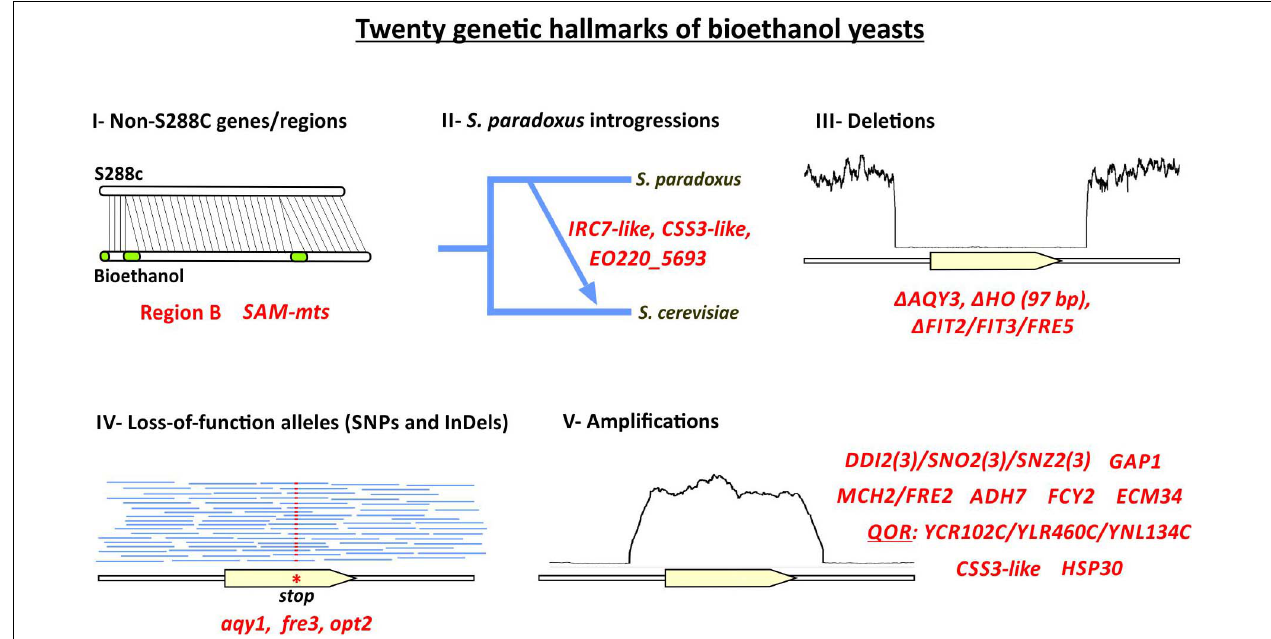
FIGURE 6 | Twenty genetic hallmarks of Brazilian bioethanol yeasts. Genetic features enriched ( p < 0.05) in bioethanol yeasts are shown in red, including: (i) non-S288C genes, (ii) putative introgressions from S. paradoxus , (iii) large deletions, (iv) SNPs and small InDels, (v) amplified